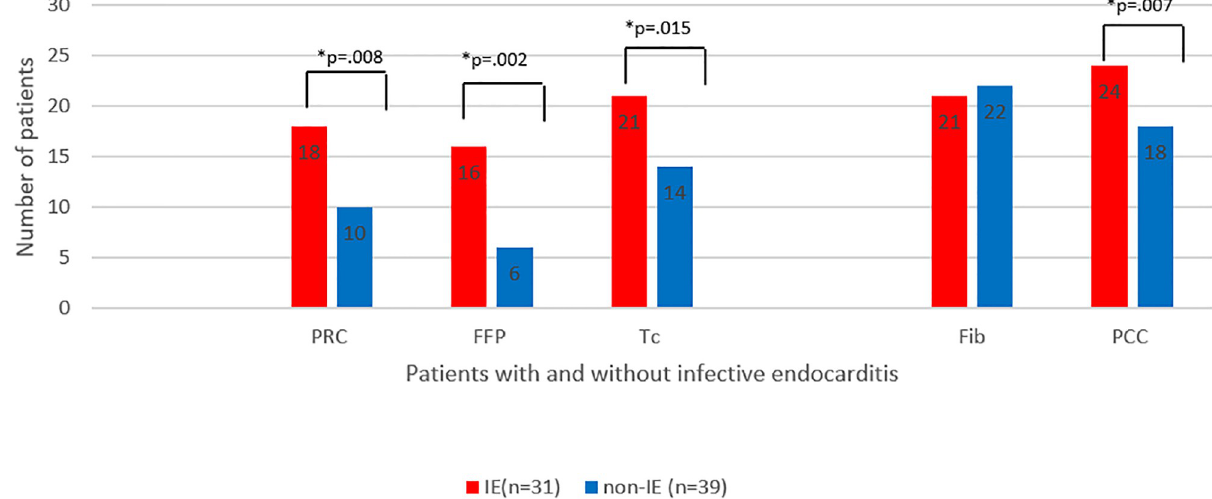
Fig 4. Number of patients receiving transfusion and coagulation factors in patients with and without infective endocarditis. * Indicates statistical significance. Abbreviations: RBC = packed red cells, FFP = fresh frozen plasma, Tc = thrombocytes, Fib = fibrinogen concentrate, PCC = prothrombin complex